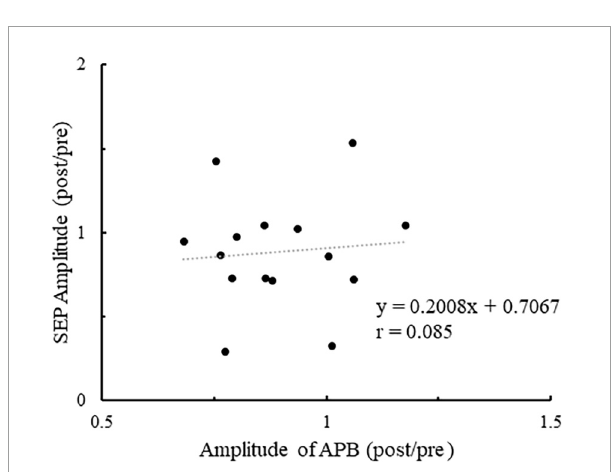
FIGURE8 The plot of the change in the muscle activity of APB relative to the change in P45 amplitude at the C3 (cid:48) electrode for all participants. Values of > 1 indicate enhancement from pre- to